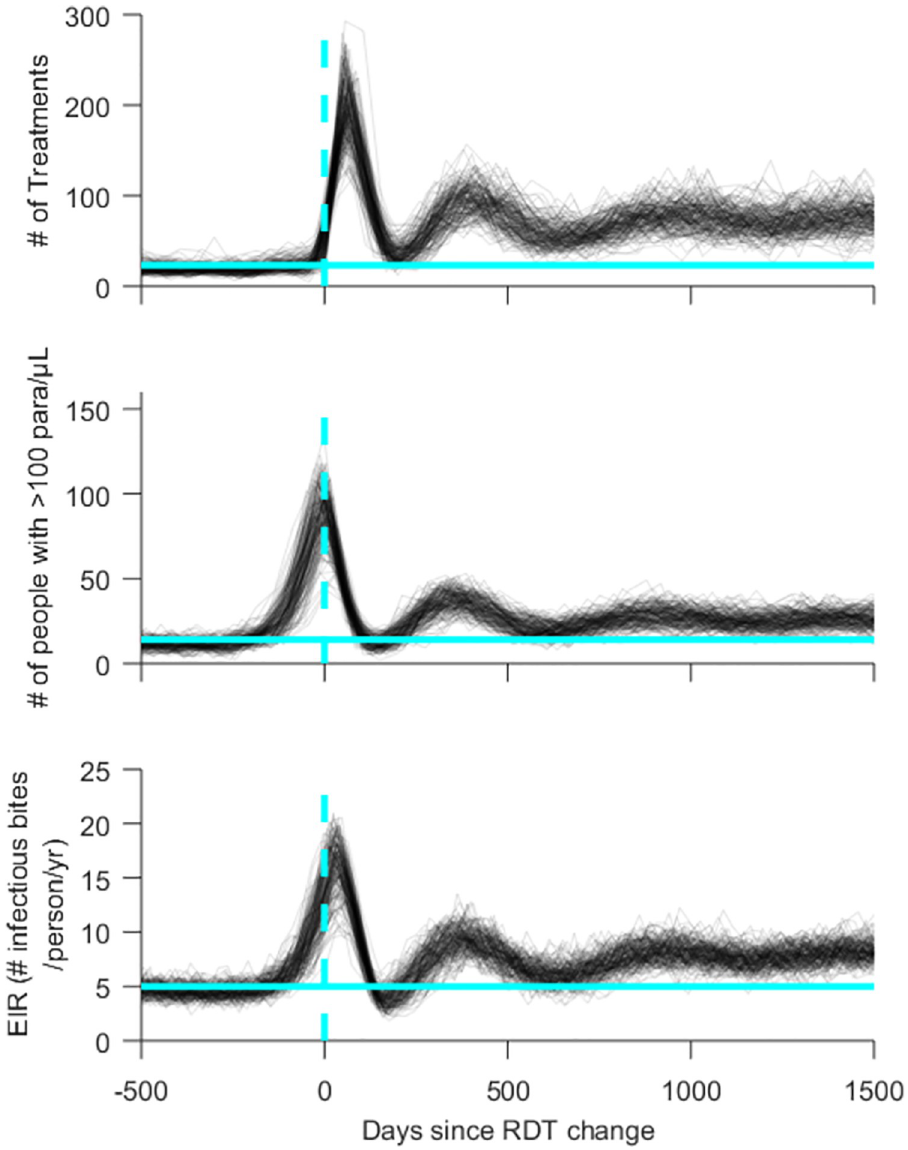
Fig 7. Simulation trajectories for number of treatments in previous 50 days, prevalence ( > 100 parasites/ μ L) and EIR in a village with moderate-low transmission where 80% of symptomatic patients seek diagnosis and treatment and a Pf-pLDH RDT is used after the false-negative RDT rate exceeds 75% (Scenario 6). Vertical dashed line: RDT change day; horizontal line: 75 th percentiles of parameters in 500 days before introduction of HRP2-negative